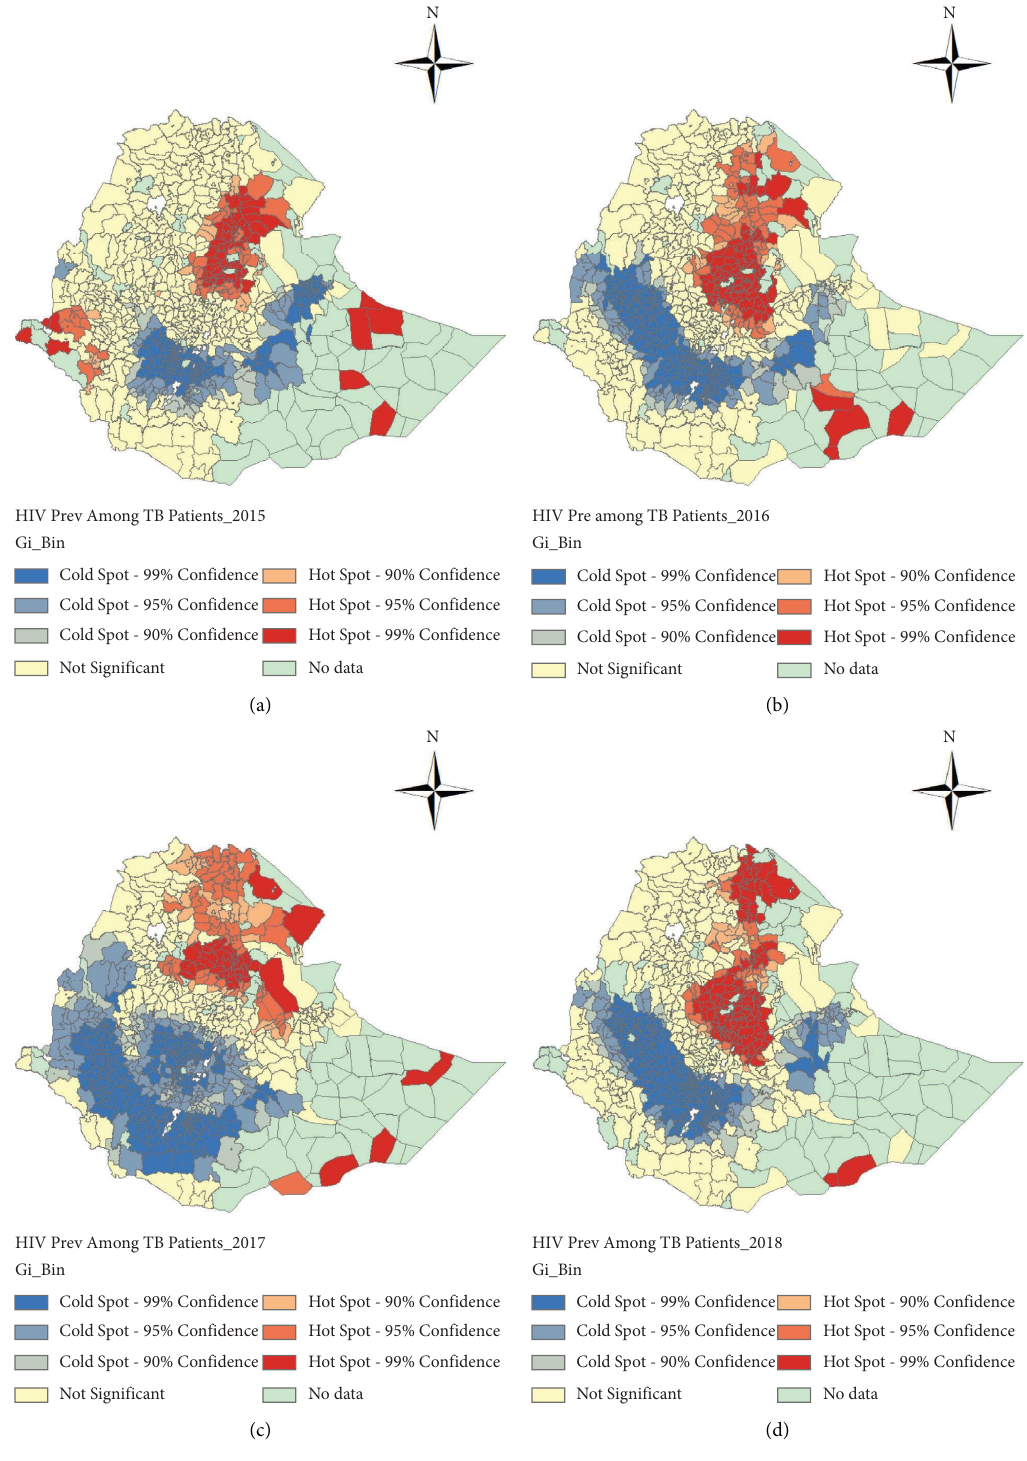
Figure 4: Spatial clustering of HIV prevalence among tuberculosis patients at district levels in Ethiopia from 2015 to 2018 using the Getis–Ord G ∗ i statistic. (a) 2015. (b) 2016. (c) 2017. (d)